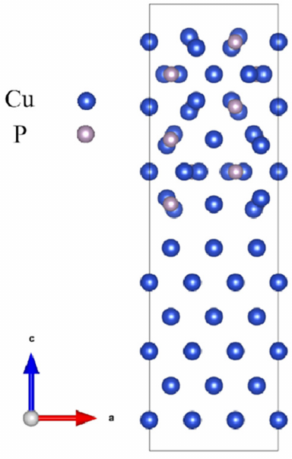
Figure 2. The interface model of Cu 3